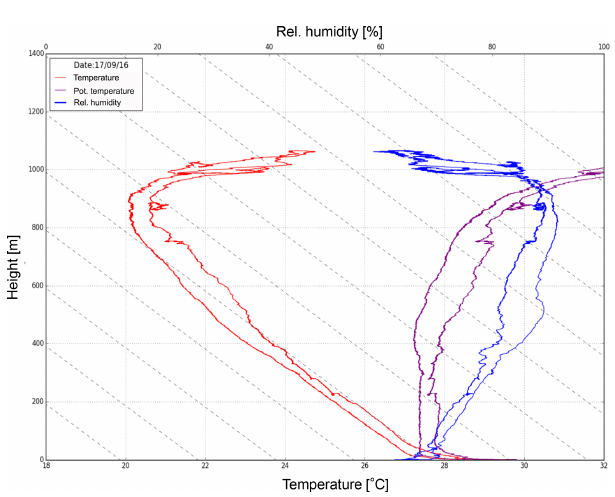
Figure 4. The measured temperature and humidity profiles at the CVAO on 17 September using a 16m 3 helikite. From the measure- ments the boundary layer height was determined (here: ∼ 850m). This figure was adapted from Fig. S3 in Gong et al. (2020a).